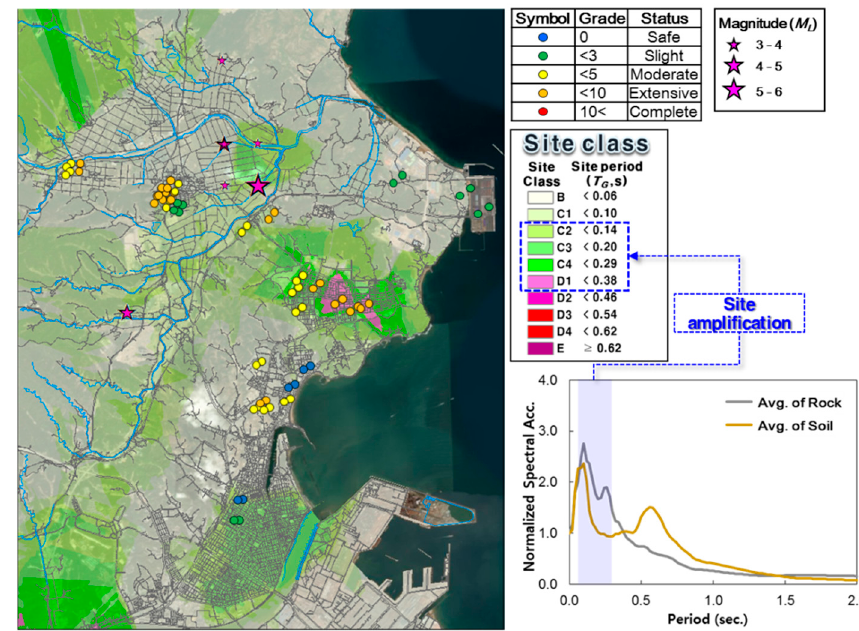
Figure 9. Spatial comparison between T G -based seismic zonation and earthquake damage category of buildings.